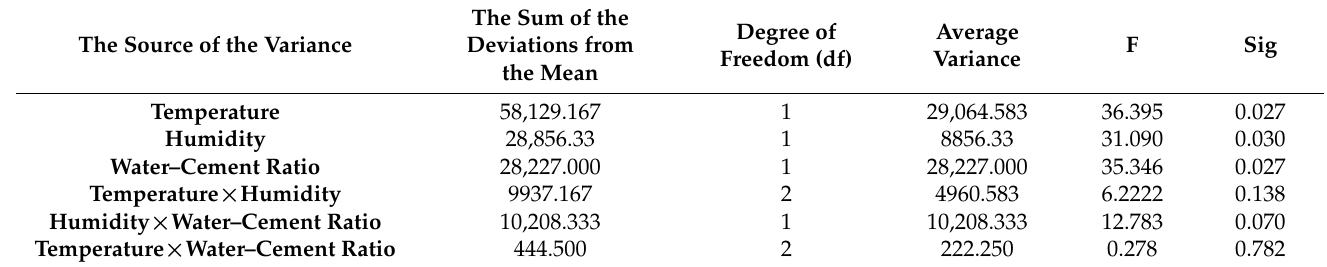
Table 5. Analysis of the effect of various factors on the shrinkage of 28-day foamed